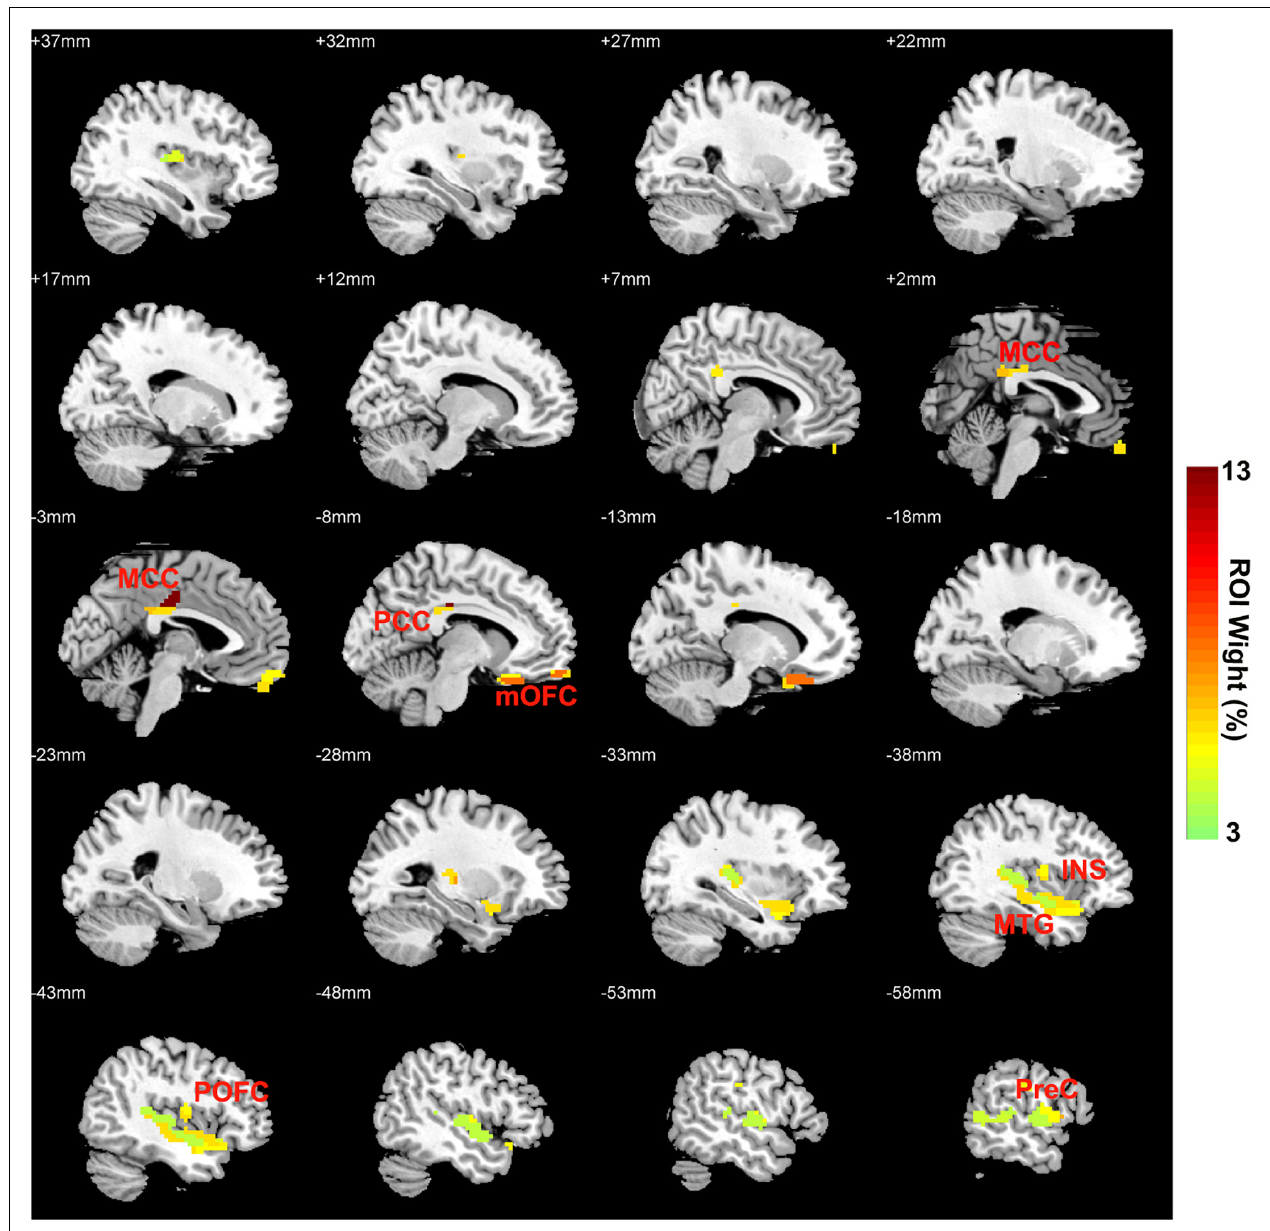
FIGURE 3 | OFC FC network weight images (per ROI) for discriminating CID-HD and CID-LD patients. OFC, orbital frontal cortex; FC, functional connectivity; CID-HD, chronic insomnia disorder with high depressive symptoms; CID-LD, CID with low depressive symptoms; MCC, middle cingulate cortex; mOFC, medial orbital frontal cortex; INS, insula; POFC, inferior par opercularis frontal cortex; PCC, posterior cingulate cortex; MTG, middle temporal